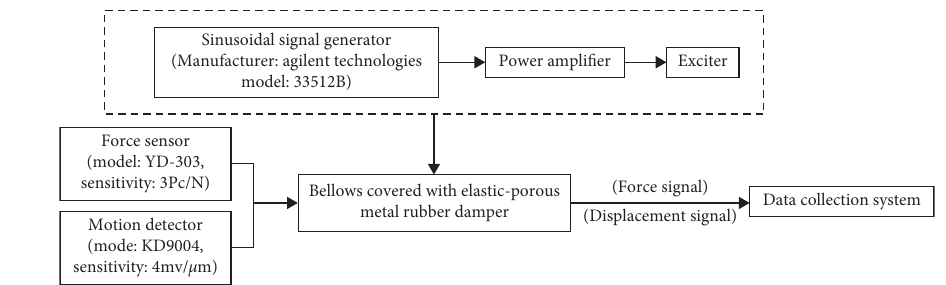
Figure 4: Schematic diagram of the dynamic test system.